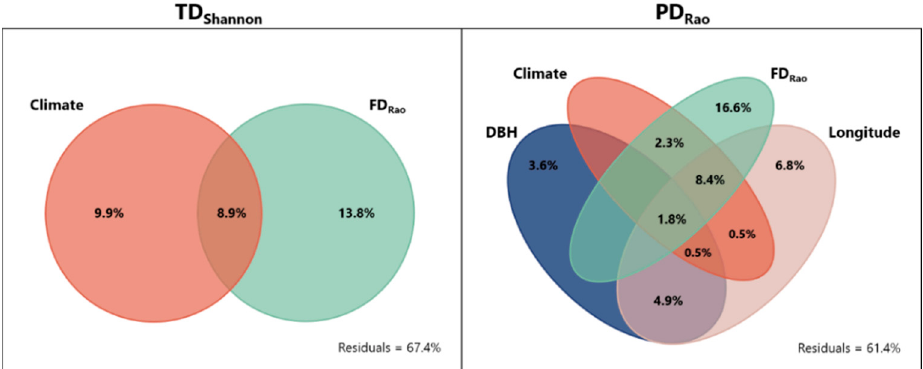
Figure 3. Variation partitioning Venn diagrams representing the unique and shared contribution (%) of climate and FD to TD variation ( left ), and DBH, climate, FD, and longitude to PD variation ( right ). The intersections represent the percentage of explained variation shared by different explanatory variables. Areas without values represent 0 or negative percentages of explained variance. Residuals represent the percentage of unexplained variation.